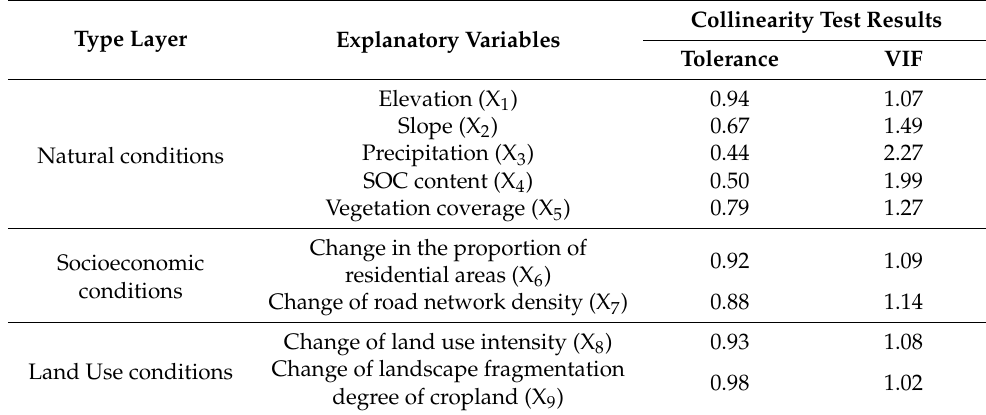
Table 4. Statistical result of regression coefficients of explanatory